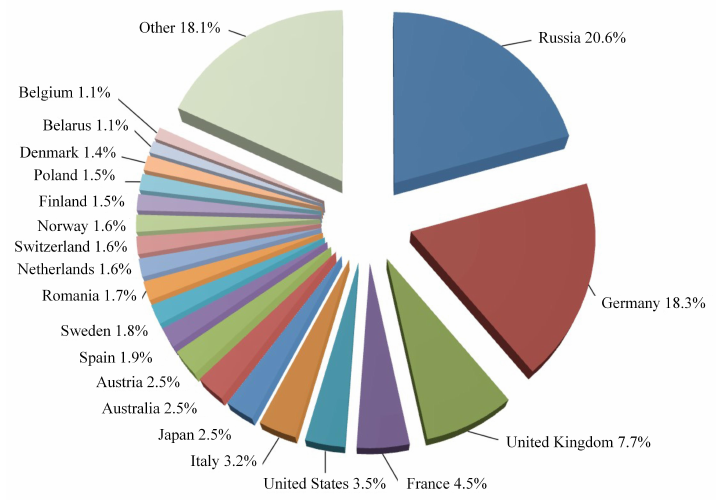
Figure 4. Distribution of POI data